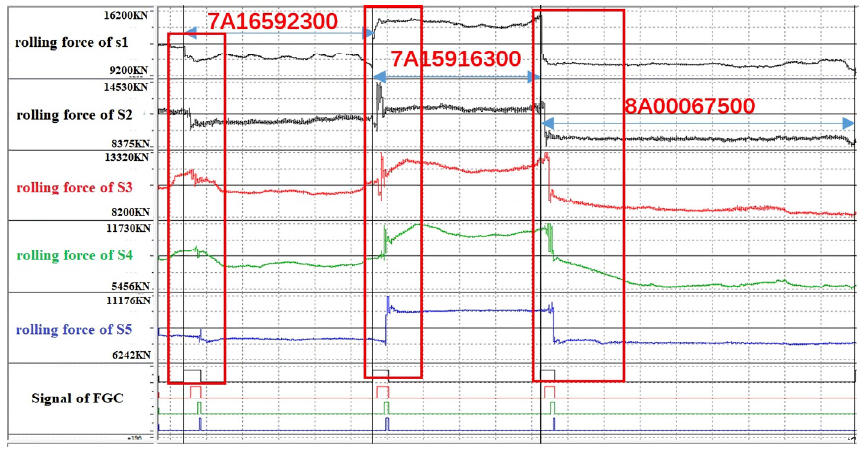
Figure 13. Rolling force of each stand before optimization.